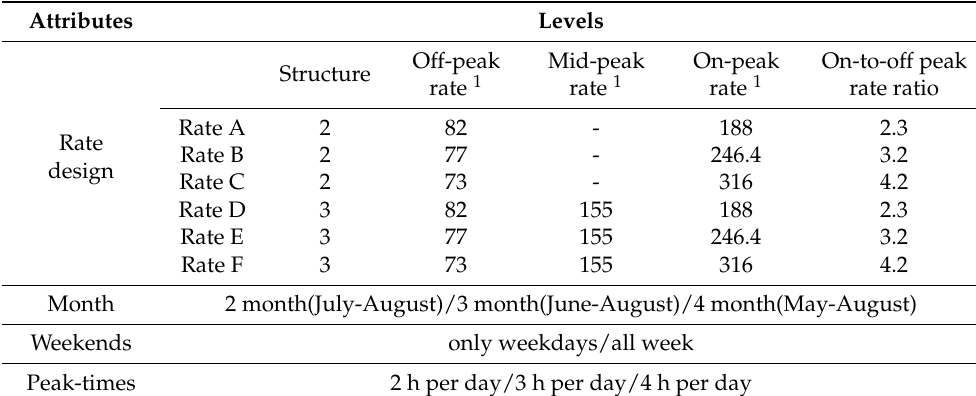
Table 1. Attributes and levels of TOU tariff in the choice experiment survey.